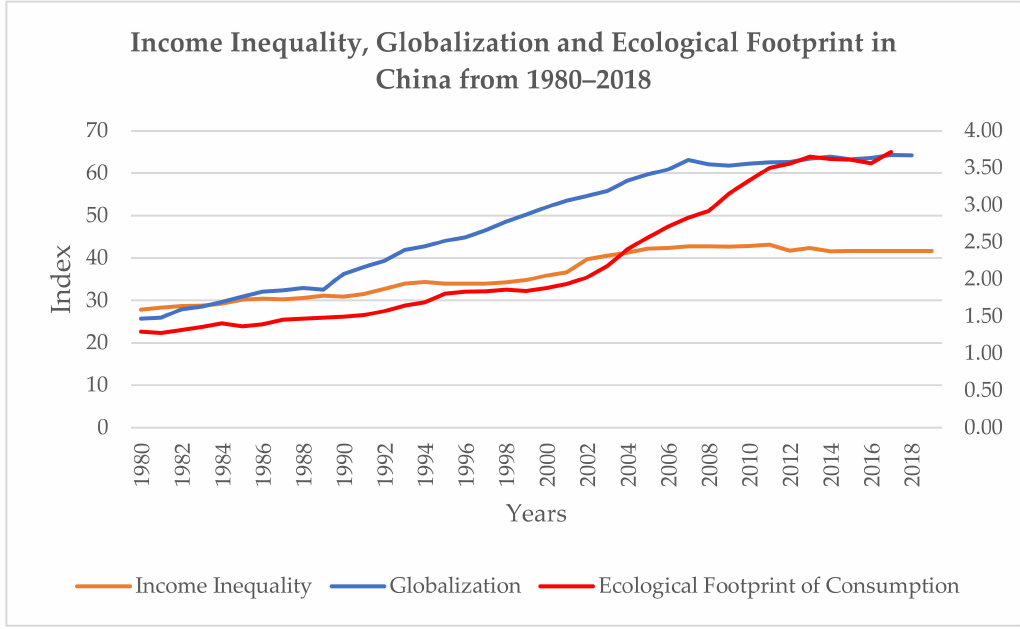
Figure 3. Income inequality, globalization and ecological footprint in China. Own illustration based on